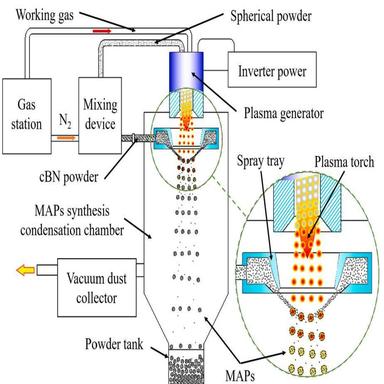
The schematic diagram of cBN-MAPs synthesis.